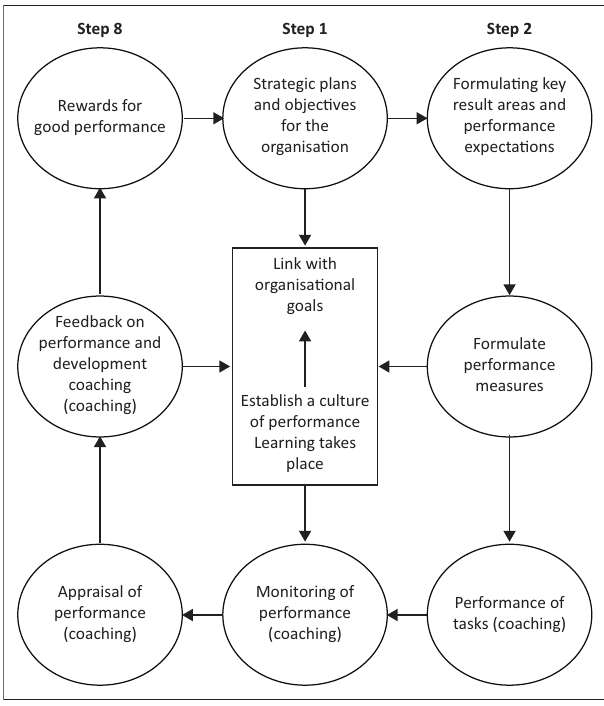
FIGURE 1: Proposed performance management